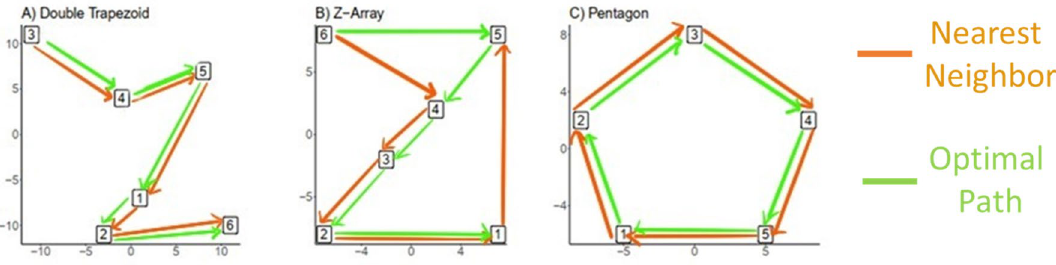
Figure 1. Design of the navigational arrays used, with ( a ) the Double Trapezoid array used for Cheirogaleus medius , Microcebus murinus , Daubentonia madagascariensis , and Chlorocebus pygerythrus . Three different arrays were built and scaled to the body size of animals (see “Methods”). ( b ) The Z-array used for C. pygerythrus and Macaca fuscata . The same size array was used for both species because they are similar in adult body lengths (vervet mean range from four sites: 34.5–42.6 cm 51 , Japanese macaque mean range from six sites: 48.9– 59.7 cm 52 . ( c ) The Pentagon used for C. pygerythrus. Distances here are unitless but roughly proportional to the body size of each species tested. Created in R version 4.0.4 and